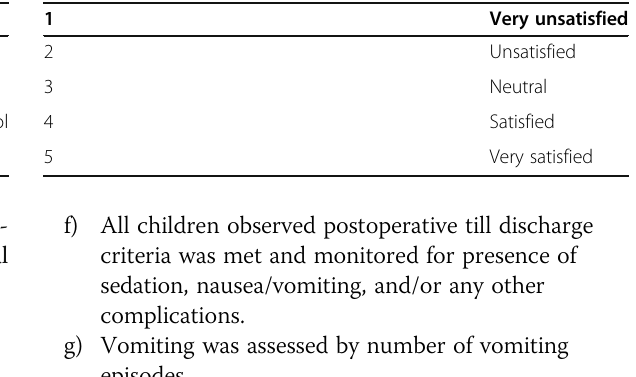
Table 2 Groningen distress rating scale (GDRS) (Chau et al., 2019) Table 4 Parent satisfaction score (Neville et al., 2016)